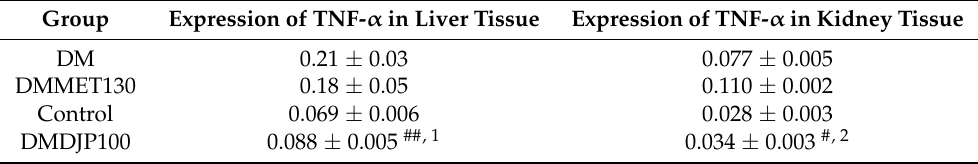
Table 3. Immunohistochemical expression of TNF- α of liver/ kidney tissue in the mice. Group Expression of TNF- α in Liver Tissue Expression of TNF- α in Kidney Tissue DM